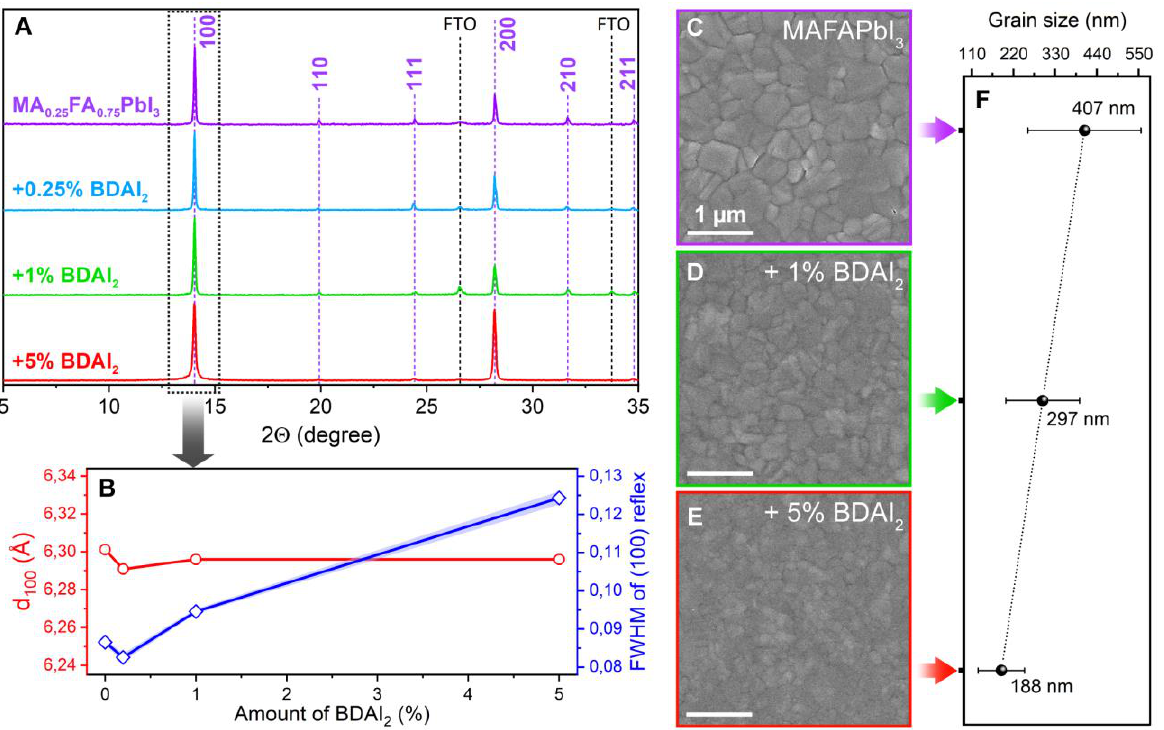
Figure 3. ( A ) XRD patterns of MA 0 . 25 FA 0 . 75 PbI 3 perovskite films with a different amount of BDAI 2 additive. ( B ) Interplanar distance (red) and FWHM (blue) of (100) perovskite reflex as a function of BDAI 2 amount. ( C – E ) Top-view SEM images of MAFAPI perovskite films without additive ( C ), with 1% BDAI 2 ( D ), and with 5% BDAI 2 ( E ). The scale bars are 1 µm. ( F ) Average grain size of corresponding perovskite films with different BDAI 2 contents.